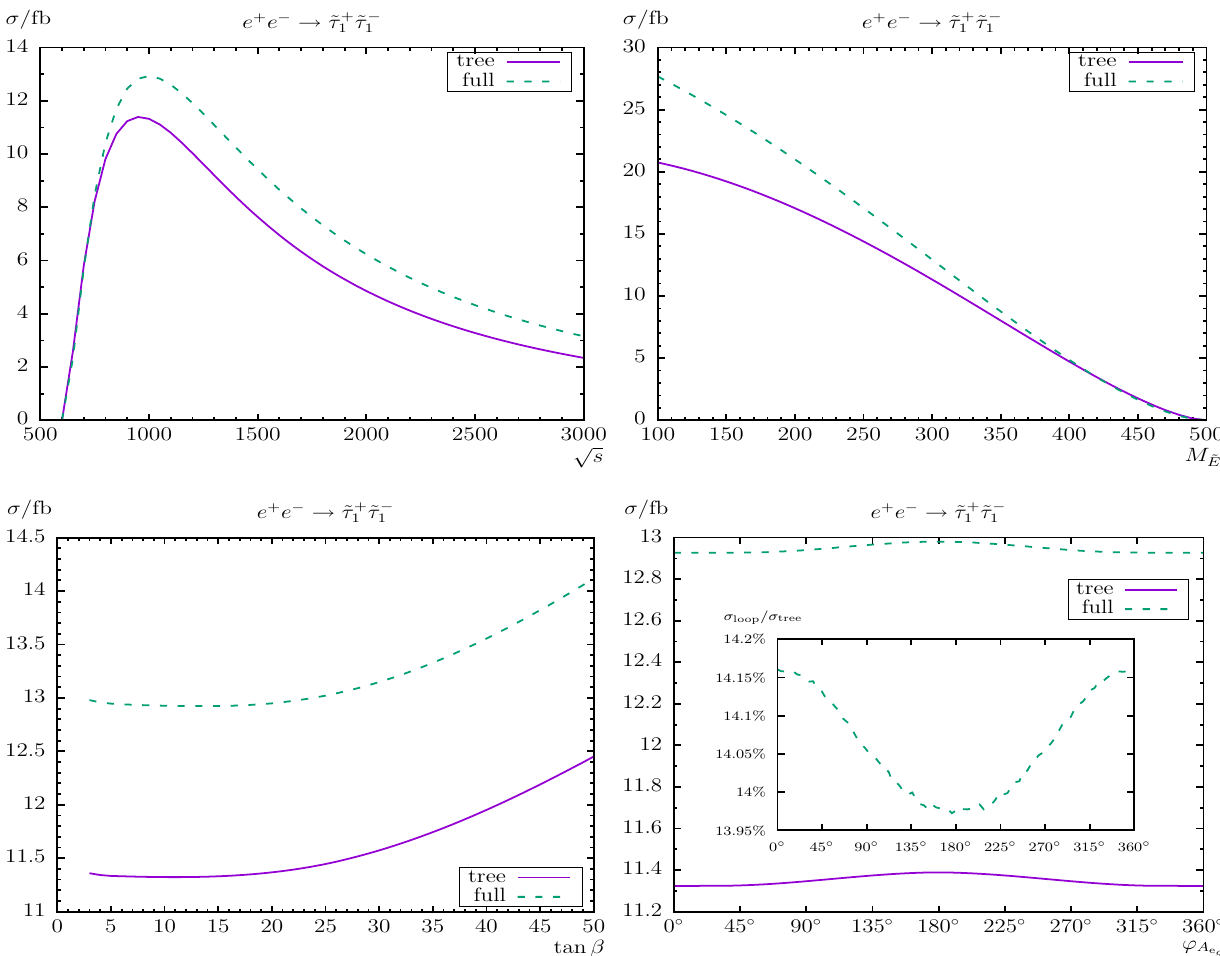
˜ τ − ) . Tree-level and full one-loop corrected cross sections are shown with parameters chosen according to S ; see Table 1. Fig. 15 σ( e + e − → ˜ τ + √ 1 1 s (left) and M ˜ The upper plots show the cross sections with (right) varied; the lower plots show t β (left) and ϕ A E energies are in